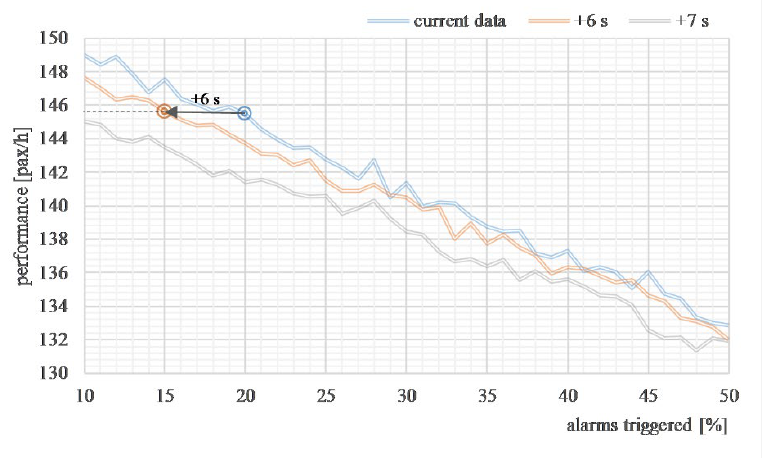
Figure 9. The concept of reducing the number of alarms triggered by increasing operator assistance time.